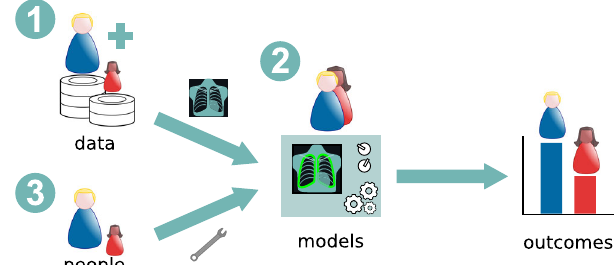
Fig.2|MainpotentialsourcesofbiasinAIsystemsforMIC. Thedatabeingfedto thesystemduringtraining(1),designchoicesforthemodel(2),andthepeoplewho develop those systems (3), may all contribute to biases in AI systems for